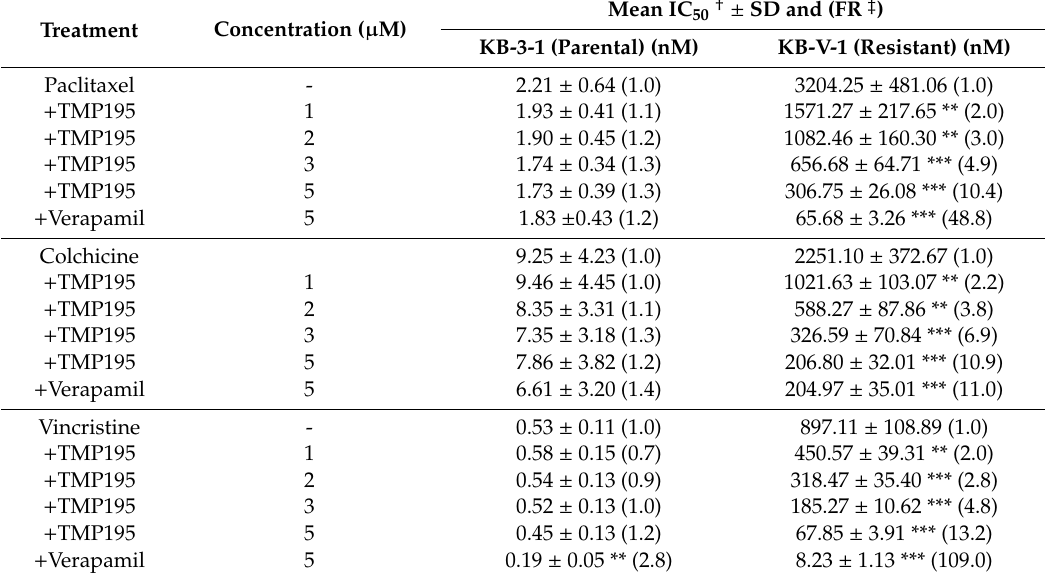
Table 2. Chemosensitizing e ff ect of TMP195 on multidrug resistance mediated by ABCB1 in ABCB1-overexpressing human cancer